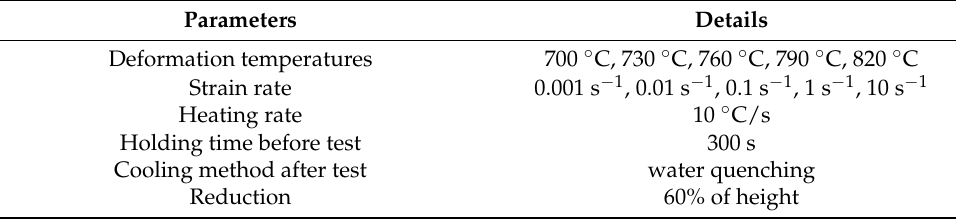
Table 2. Detailed parameters of high-temperature compression